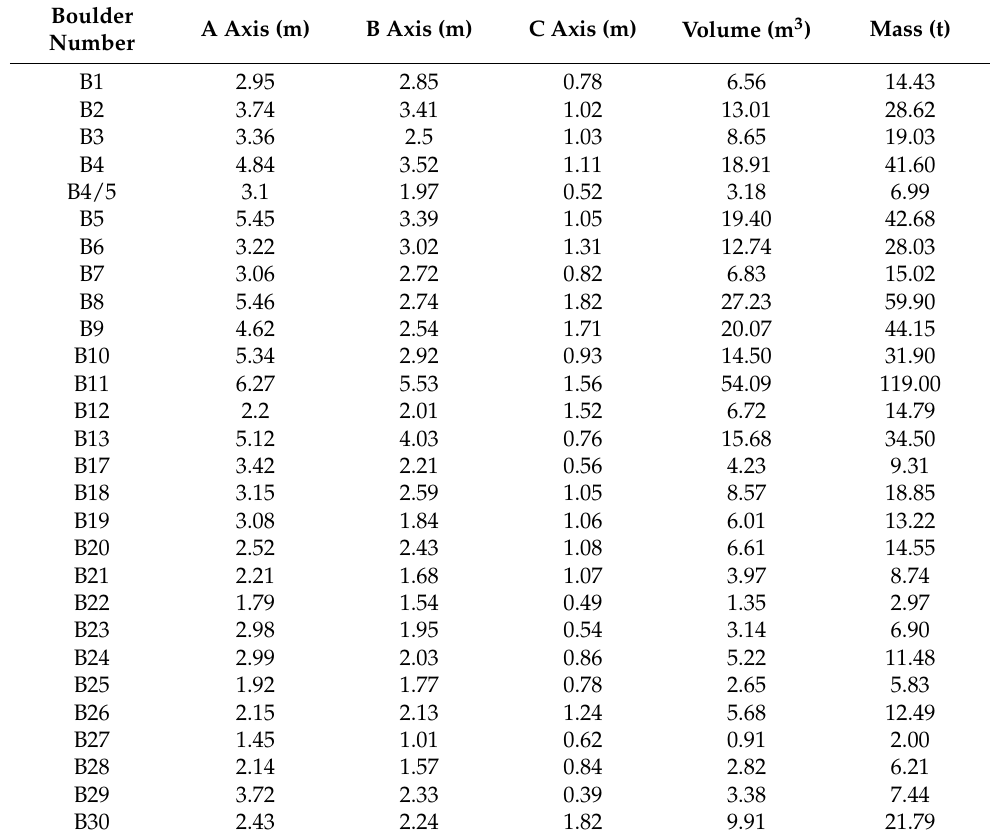
Table 3. A, B, and C axis sizes, volume, and mass of the 31 selected boulders.